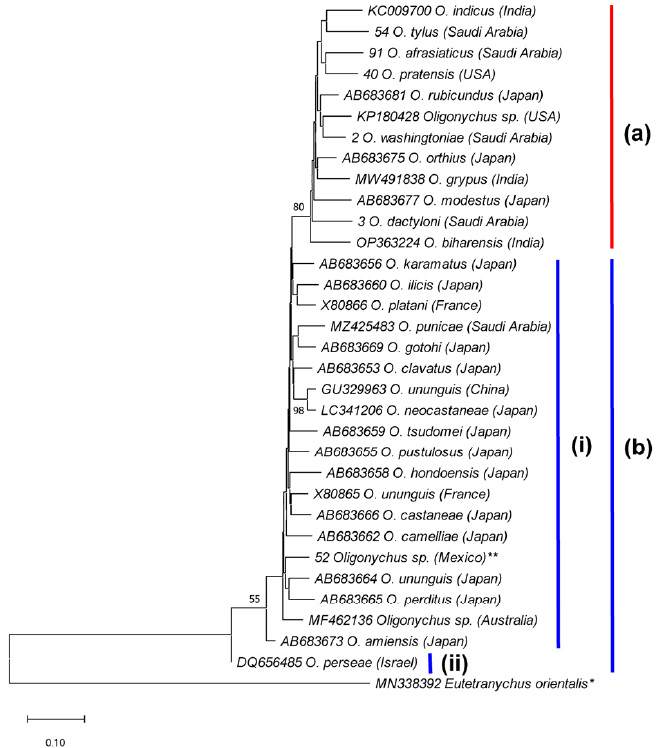
Figure 8. NJ phylogenetic tree based on 33 COI sequences, representing 32 Oligonychus species. Eutetranychus orientalis * was used as an outgroup taxon. A total of 12 Oligonychus species belong to the subgenus ( a ) Reckiella , whereas 18 Oligonychus species (** including a cryptic Oligonychus sp., previously claimed as O. punicae from Mexico) [7] belong to the species groups ( b - i ) coffeae and ( b - ii ) peruvianus of the subgenus Oligonychus [3]. Numbers on tree branches are bootstrap values obtained from 1000 replicates.